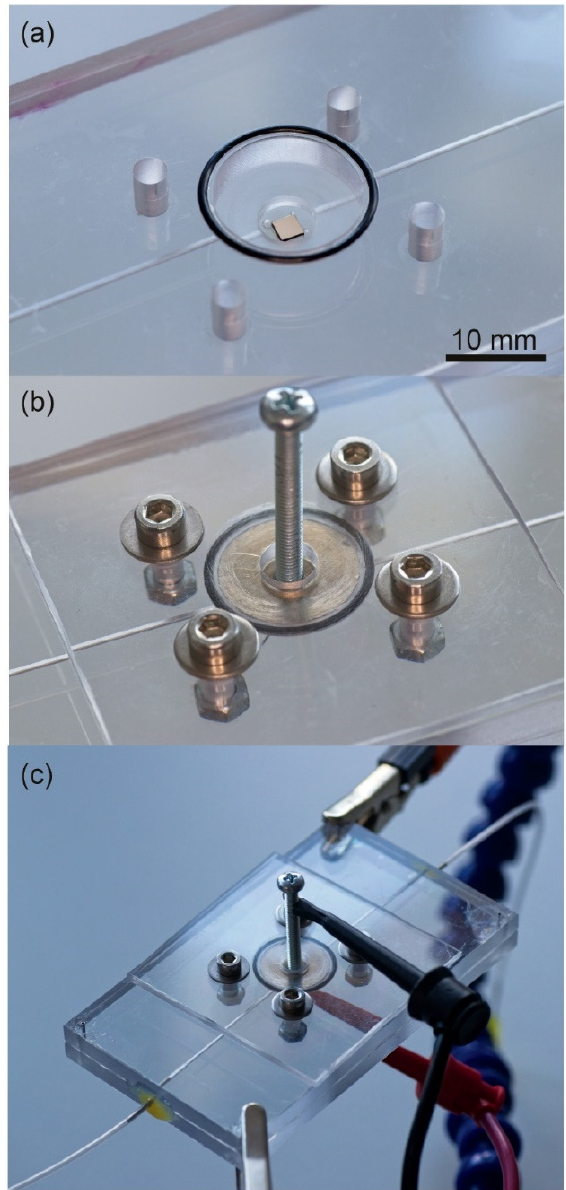
Figure 2. Bottom plate of the microfluidic chip for the dielectrophoretic deposition of CTCs with the SERS platform at the very center and chamber for the DEP counter-electrode and sealing ( a ); bottom plate with the DEP electrode closed with a top plate and assembled with four M3 bolts ( b ); view of the assembled microfluidic chip with a connected signal generator and PE tubing running to a syringe pump ( c